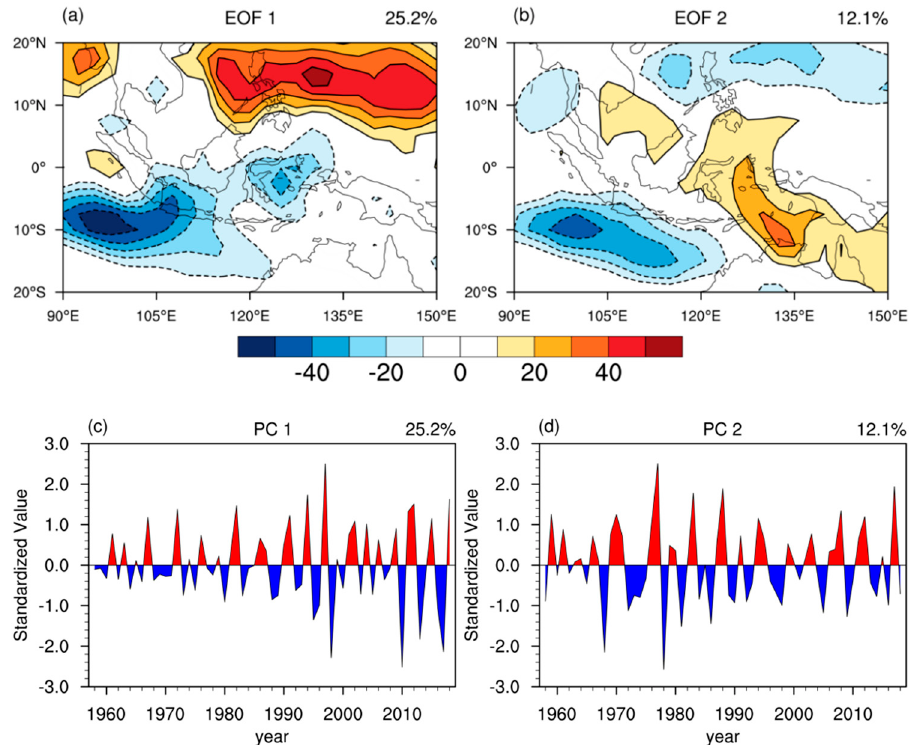
Figure 1. ( a , b ) The first and second eigenvectors (EOF1, EOF2) of JJA–mean (cid:104) Q 2 (cid:105) anomalies over the tropical eastern Indian Ocean-western Pacific (TEIOWP) for the period of 1958 to 2018; ( c , d ) the corresponding normalized time series (PC1 and PC2). The explained variance is indicated at the top right; the zero contours are omitted.